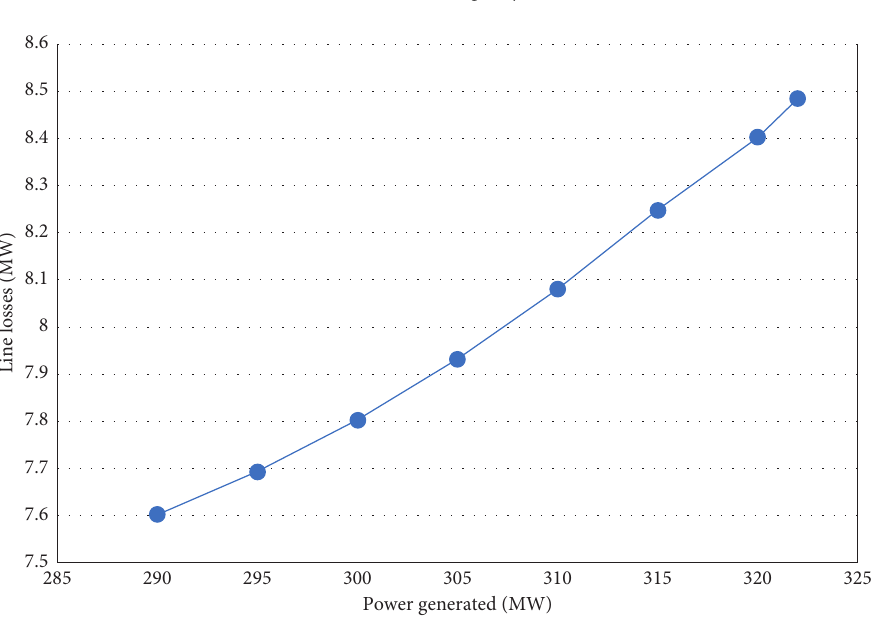
Figure 6: Generation contingency characteristics.